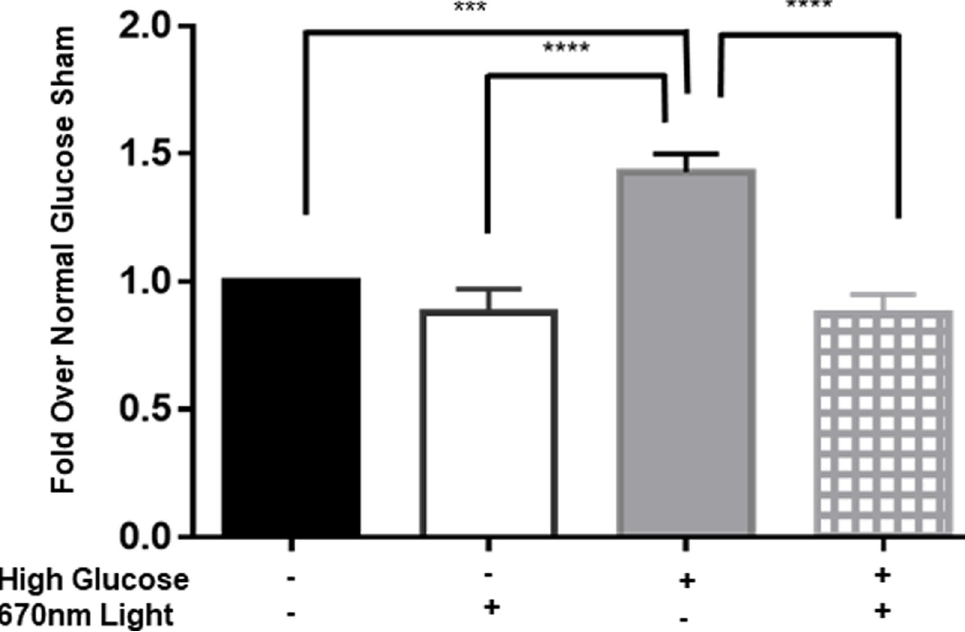
Fig 2. 670 nm light treatment diminishes oxidative stress under high glucose conditions in Muller cells. Bar graph displaying ROS production in rMC-1 cells. Cells were cultured in either normal glucose (black bars and white bars) or high glucose (gray bars and hashed bars) medium for 24 hours. 670nm or sham control was applied to the cells at 4.5 J/cm 2 . Oxidative stress was analyzed using DCF-DA. One-way ANOVA statistical analysis yielded ��� p < 0.001, ���� p < 0.0001. Three separate experiments were performed in triplicate.